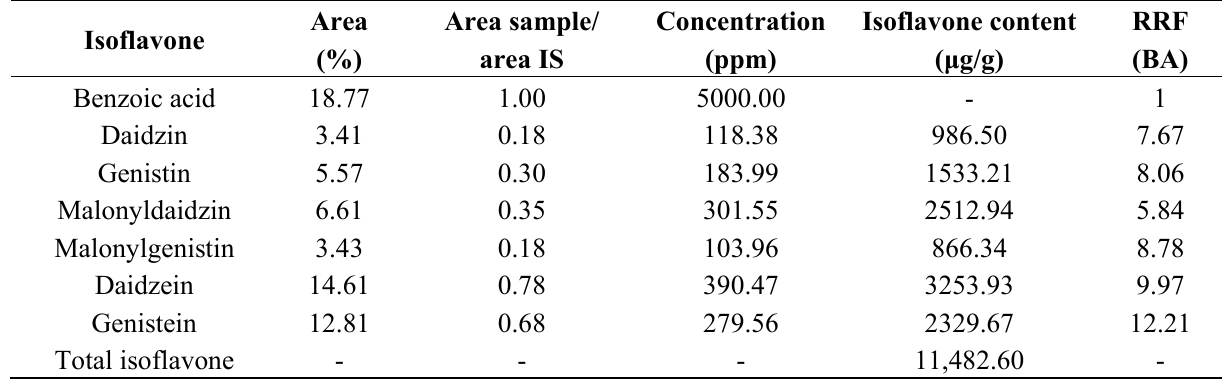
Table 1. Isoflavone contents of black soybean koji